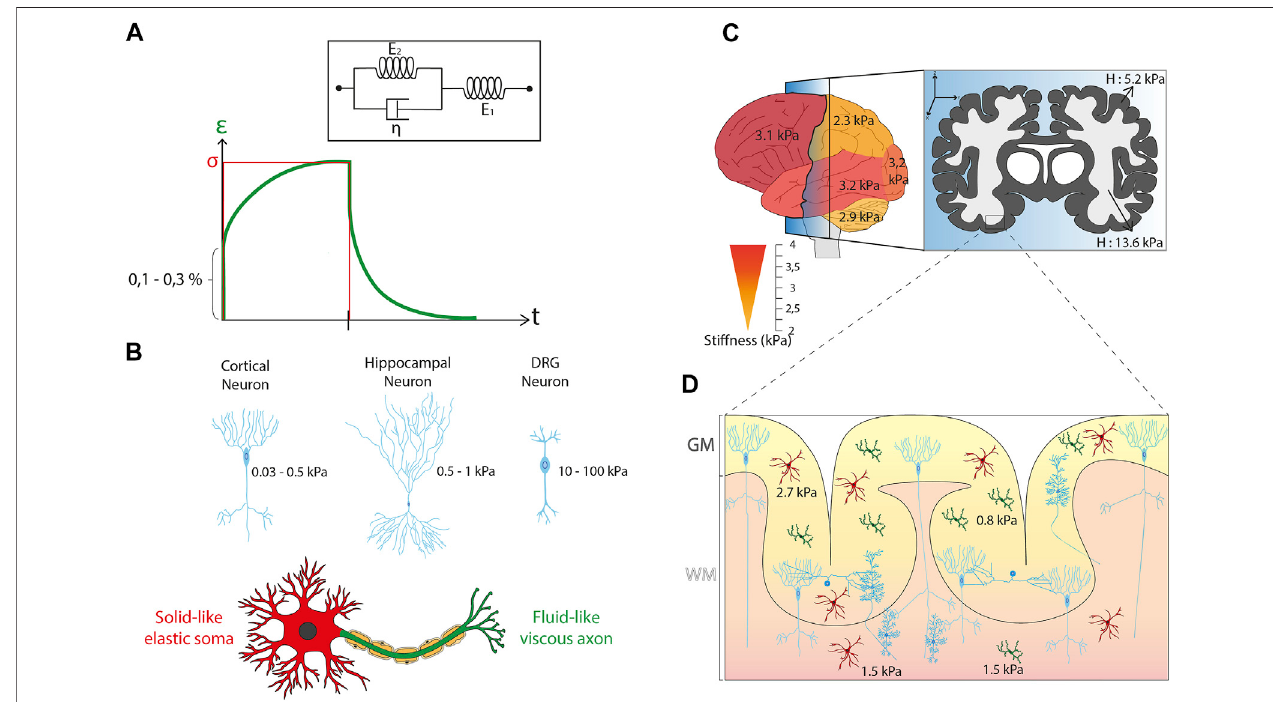
FIGURE 2 | Mechanical properties of brain cells and tissues. (A) Kelvin-Voigt representation of the Standard Linear Solid (SLS) model that describes a viscoelastic material with two systems in series. The fi rst system is called the Kelvin arm and is formed by a spring (E 2 ) and a dashpot ( η ) in parallel. The other arm is only made of a spring (E 1 ). These SLS model predicts the temporal evolution of the strain ( ε , solid black curve) in response to the application of a constant stress ( σ ) depicted in red line. (B) Sagittal view of the normal human brain color-coded with a gradient of stiffness starting from yellow (~2 kPa) to red (~4 kPa) that illustrates the differences of mechanical properties in brain tissues according to the different regions of interest. Parietal lobe and cerebellum are softer than frontal, parietal, and occipital lobes. The frontal section illustrates the anatomical distribution of white (~13.6 kPa) and grey (~5.2 kPa) matter. (C) Illustration of the mean stiffness observed in different neuron types. A cortical neuron exhibits a typical stiffness between 0.03 and 0.5 kPa, a neuron from the hippocampus shows a stiffness of 0.5 – 1 kPa, and a DRG neuron is characterized by a mean stiffness of 10 – 100 kPa. The mechanical compartmentalization of a neuron is presented with a solid-like elastic Soma (in red) and a fl uid-like viscous axon (in green). (D) Cross-section of the cerebral cortex indicating the individual mechanical properties of the glial cells as well as their spatial differences with values of ~0.85 kPa for cortical microglia cells, ~1.5 kPa for subcortical microglia cells, ~2.7 kPa for cortical astrocytes and ~1.5 kPa for subcortical astrocytes. It is interesting to note the non-homogeneous distribution of glial cells in brain tissues with a larger cell density in grey matter.